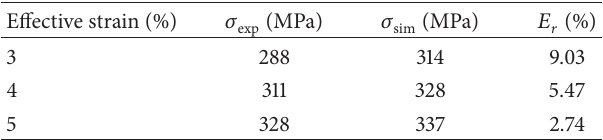
Table 3: Comparison between experimental and simulated stresses at various effective strains with a prior creep strain of